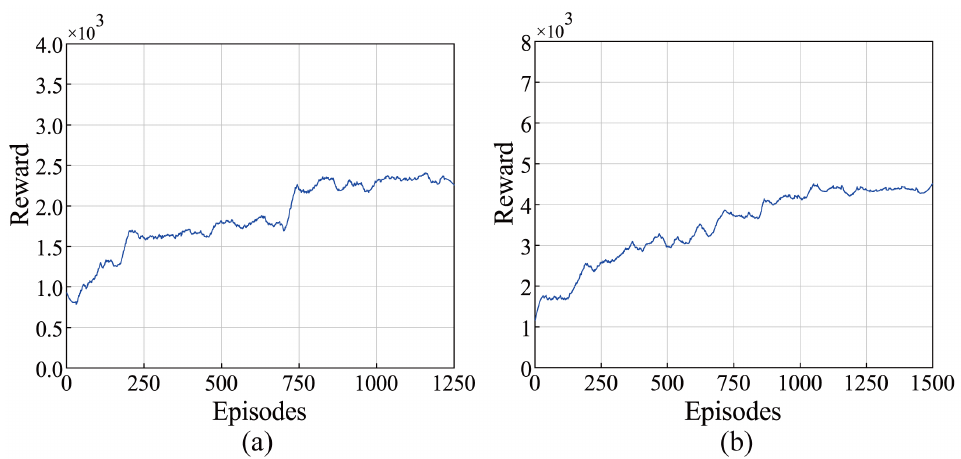
Figure 12. Reward per episode on different prediction models. ( a ) Medium coarse gravel. ( b ) Small coarse